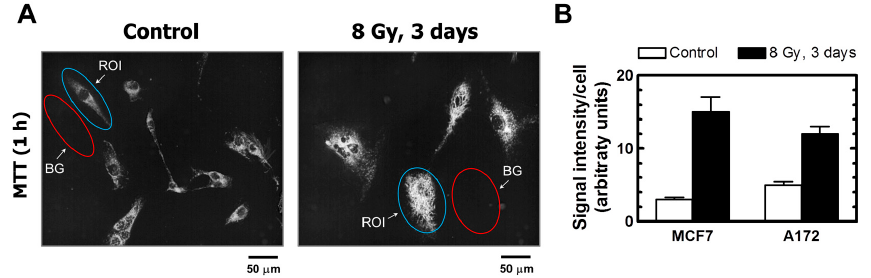
Figure 5. ( A ) Representative images of A172 cells used for image analysis. The images of MTT metabolites were acquired as described in Figure 4 legend (upper row). The images were then converted to grayscale and inverted. Blue and red ovals mark some regions of interest (reflecting MTT metabolites) and corresponding background regions used for image analysis, respectively. ( B ) Densitometric evaluation of MTT metabolic activity for the indicated cultures, expressed as signal intensity for regions of interest (cells) after corresponding background corrections. Mean values for at least 30 cells are presented for each sample. Bars, SE. ROI, region of interest; BG,